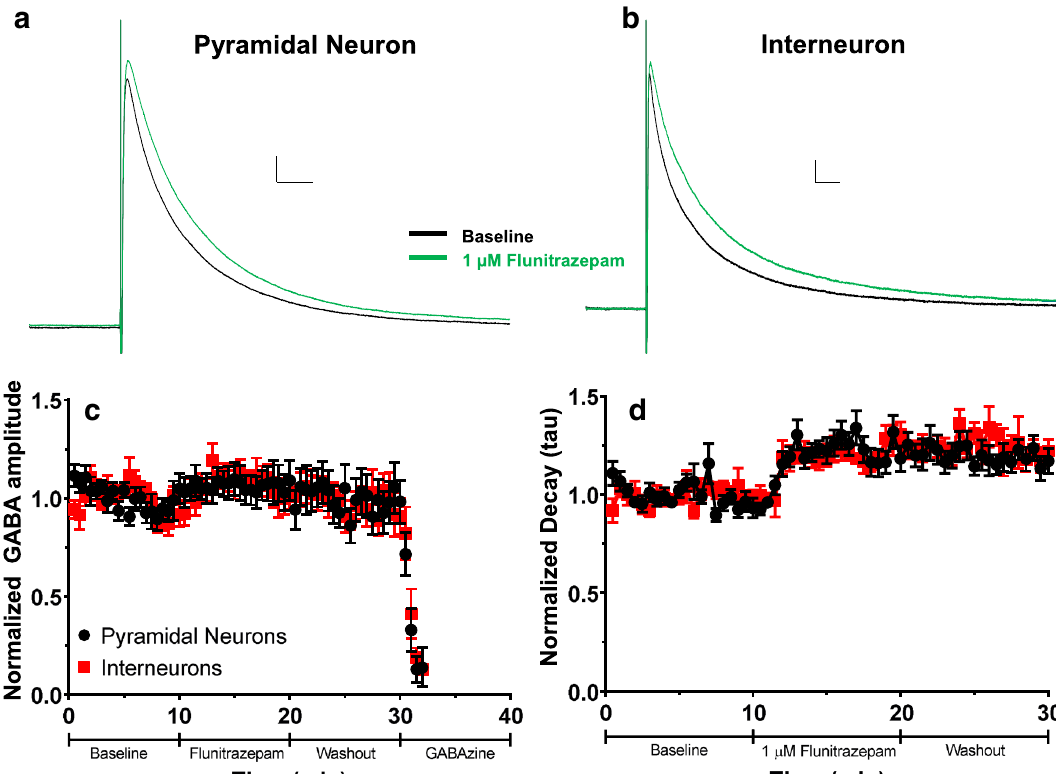
Figure 3. Effect of acute flunitrazepam application on evoked GABA A receptor-mediated postsynaptic current (GABA A -ePSC) amplitude and decay in layer V pyramidal neurons and INs. ( a ) Average ePSC traces from layer V pyramidal neurons during the baseline (black trace) and acute 1 µM flunitrazepam application (green trace) phases. Scale bars 40 ms, 50 pA. ( b ) Average GABA A -ePSC traces from layer V INs during the baseline and acute 1 µM flunitrazepam application phases. Scale bars 40 ms, 20 pA. ( c ) Normalized GABA A -ePSC amplitudes for both pyramidal neurons (black circles) and INs (red squares) in layer V during the baseline, 1 µM flunitrazepam, washout, and gabazine application phases. ( d ) Normalized decay constants (tau) for both pyramidal neurons and INs during the baseline, 1 µM flunitrazepam, and washout phases. Data are presented as mean ± tau Fig. 4i; IN tau Fig. 4j). INs had a higher tau value than pyramidal neurons, indicating that GABA A -sPSCs decayed more slowly in INs than pyramidal cells (cell type F(1,12) = 13.543, p = 0.0031, η p 2 = 0.530). Experiment 2: long‑term effects of P7 ethanol vapor chamber exposure on oIPSCs in layer V pyramidal neurons in the ventral RSC. Third trimester-equivalent ethanol exposure has been shown to trigger apoptosis and long-term loss of INs, including PV+ INs, in the RSC 25,28 , which could lead to per- sistent alterations in GABAergic neurotransmission. To examine this possibility, we used a transgenic mouse model (B6 PV cre -Ai27D mice) that allowed us to optically stimulate PV+ INs specifically. We assessed whether PV+ IN-mediated oIPSCs in RSC layer V pyramidal neurons of adolescent mice are affected by P7 developmen- tal ethanol exposure. We first determined the penetrance and specificity of transgene expression before starting electrophysiology experiments. We also determined if P7 ethanol exposure altered either of these measures. Male and female mice from both P7 vapor chamber exposure conditions were left undisturbed until P40–P60 and then processed for immunohistochemistry to analyze both PV expression and ChR2/tdTomato expres- sion. Representative IHC images from B6 PV cre -Ai27D mice appear in Fig. 5a–d. In air exposed animals, mean transgene penetrance was 98.67 ± 1.33% (percentage of PV+ cells expressing ChR2-tdTomato), while in etha- nol exposed animals transgene penetrance was 98.82 ± 1.18% (Fig. 5e; air male n = 3 animals from 3 litters, air female n = 2 animals from 2 litters; ethanol male n = 3 animals from 3 litters, ethanol female n = 2 animals from 2 litters). Transgene penetrance was not different between vapor-chamber exposure conditions (Mann–Whit- ney U(n1 = n2 = 5) = 12, p > 0.99, r = 0.047). We also measured transgene specificity to see if ChR2-tdTomato was aberrantly expressed in PV-negative cells. In air exposed animals, non-specific transgene expression (% of